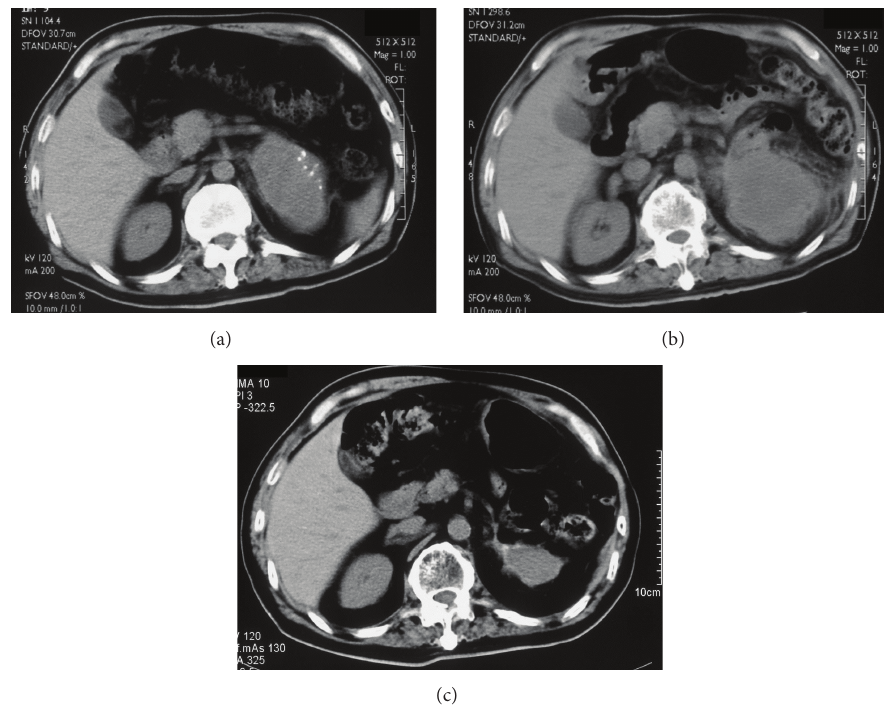
Figure 1: Abdominal computed tomography (CT) image of a left adrenal mass. (a) A preoperative CT scan revealing a 7 × 6 cm tumor with calcification. (b) A CT scan taken 4 months after surgical tumor removal showing a 12 × 9cm recurrent tumor. (c) Three years after radiotherapy, the residual tumor was 4 ×